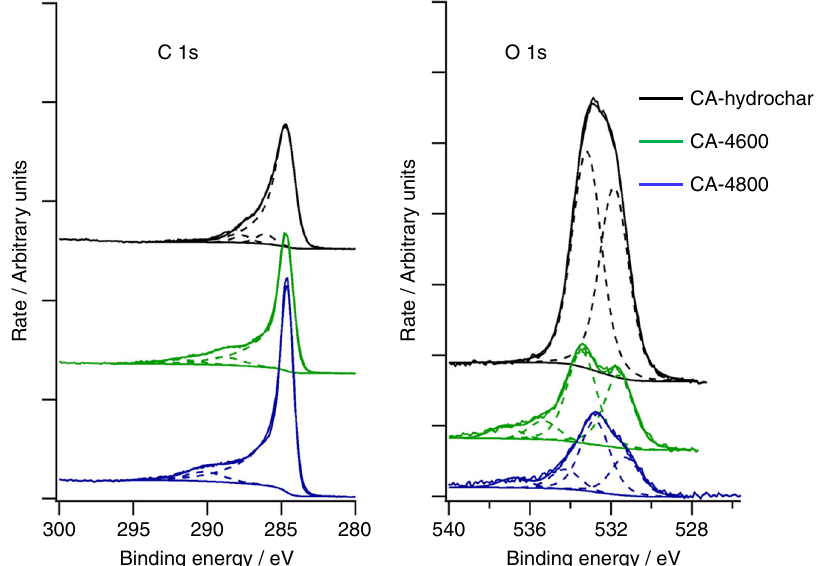
Fig. 4 C 1s and O 1s XPS spectra with peak fi tting for cellulose acetate-derived CA-hydrochar and activated carbons derived from the CA-hydrochar. The activated carbons are labelled as CA-4T, where 4 is the activation KOH/carbon ratio and T is the activation temperature in